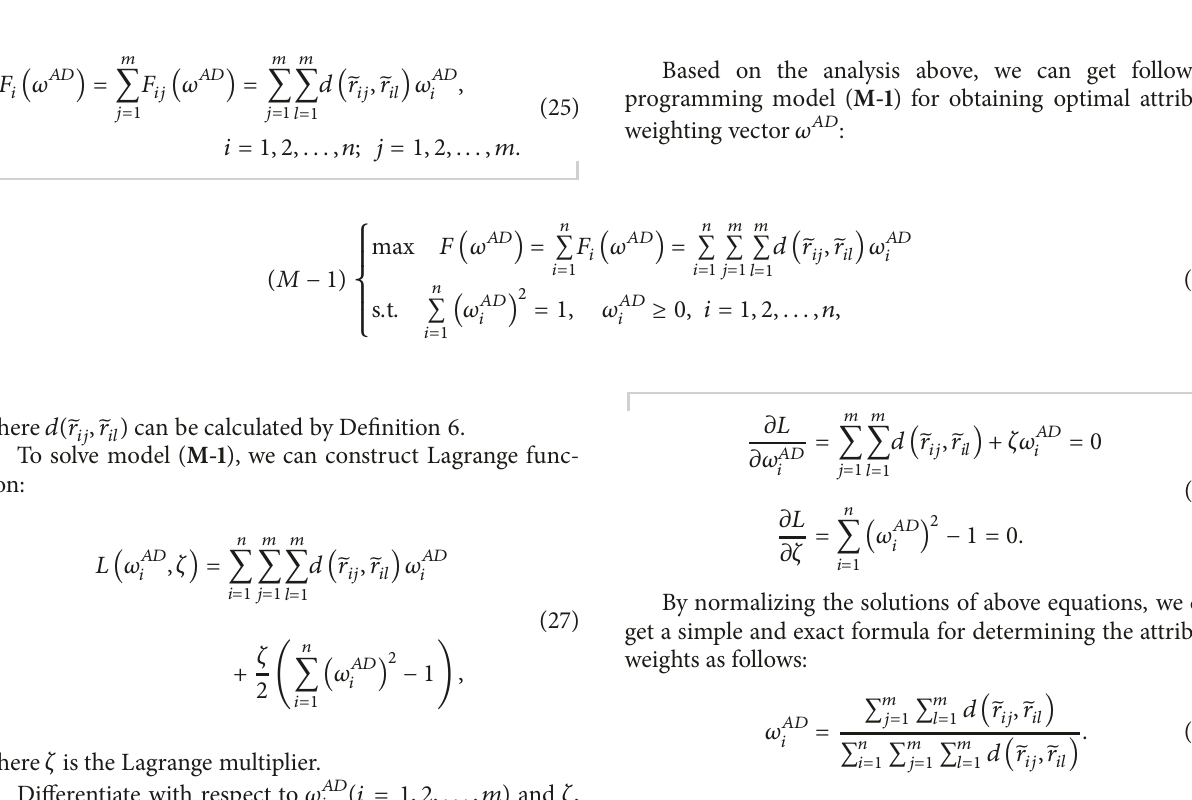
Figure 3: Processing flowchart of Algorithm